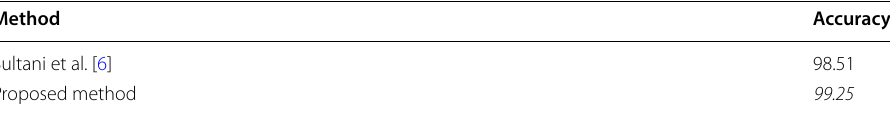
Table 4 The comparison of accuracy (%) between full-frame and our proposed locality learning